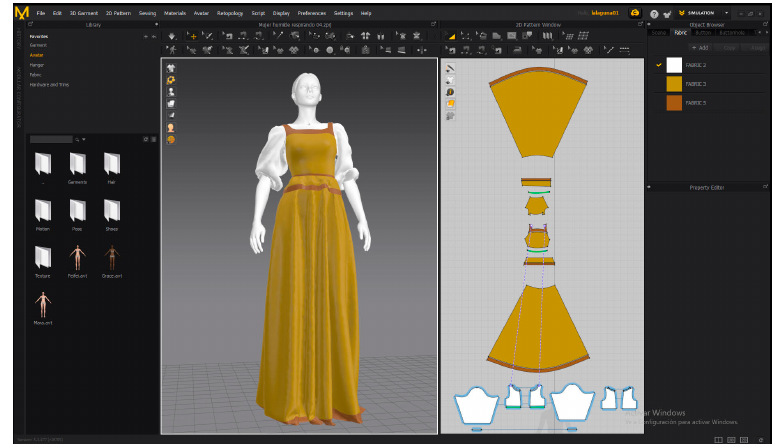
Figure 18. Clothing design in Marvelous Designer.